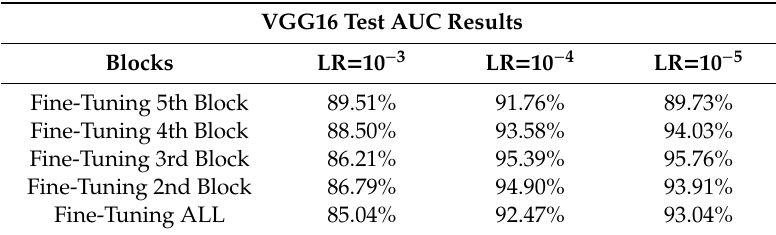
Table 6. Results of the VGG16 architecture using the BreakHis dataset.